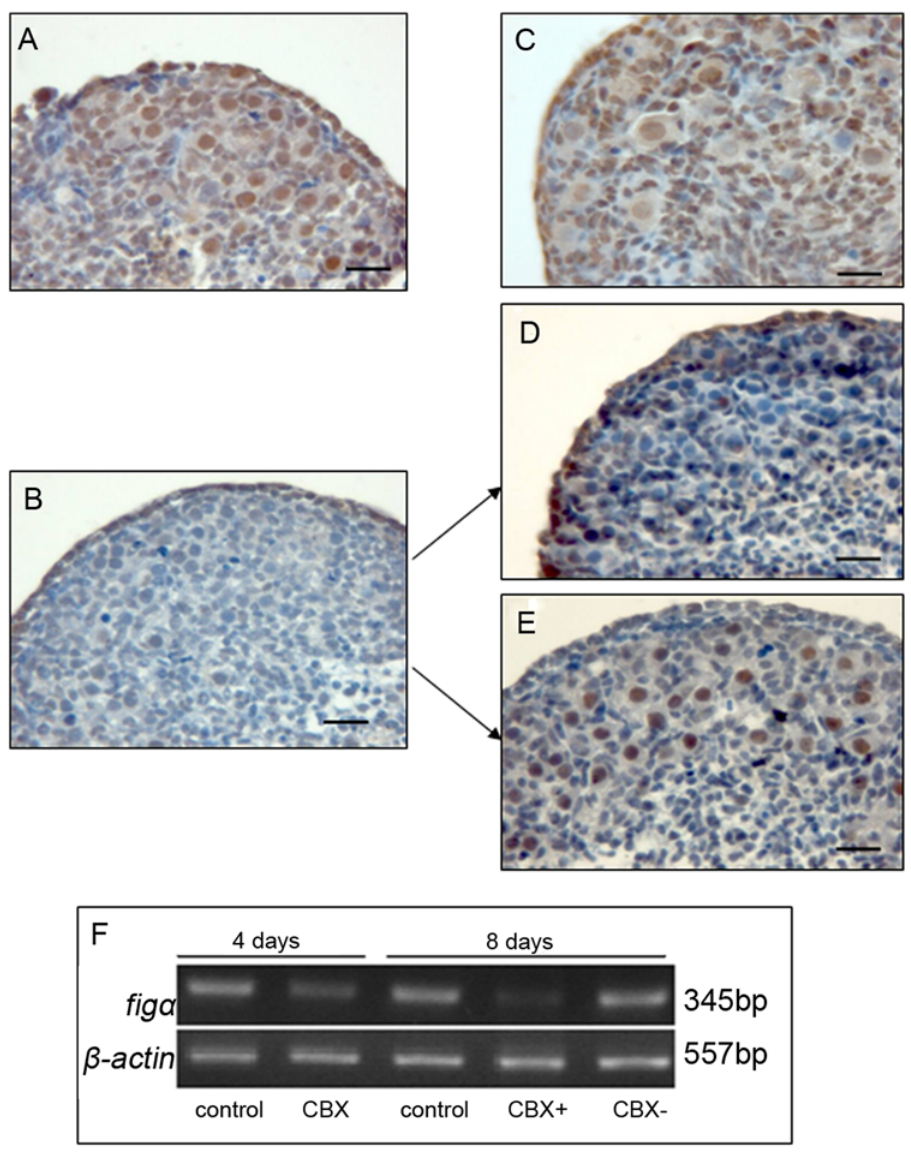
Figure 5. The effect of CBX on the PAR6 expression and follicles formation. 15.5 dpc ovaries were treated with or without CBX for 4 or 8 days, and then the follicular formation (A, B control; C, D, E CBX treatment) and the expression of Fig a gene (F) were examined. A large number of primordial follicles were observed with strong staining of PAR6 after ovaries were cultured for 4 days (A) or 8 days (B). The germ cells stayed in cyst stage with slightly staining of PAR6 in CBX treated ovaries for 4 days (C, CBX), and no follicle was observed for 8 days (D, CBX + ). Some primordial follicles were observed with strong staining of PAR6 when the ovaries were treated with CBX for 4 days and then without CBX for further 4 days (E, CBX 2 ). Bar=20 m m. CBX obviously decreased the mRNA level of Fig a (F). The experiment was repeated at least three times with similar results.